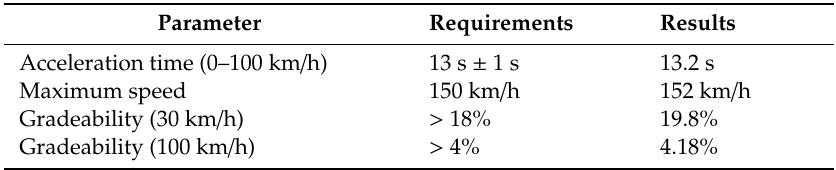
Table 14. Vehicles